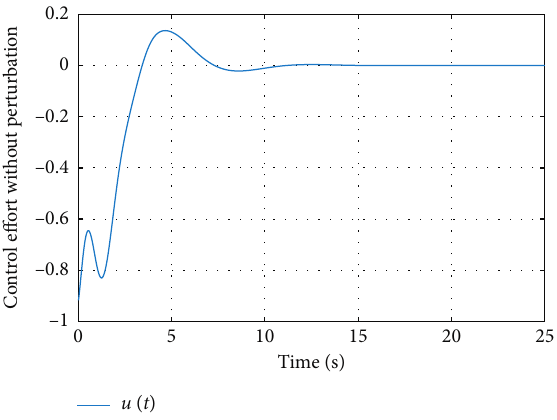
Figure 9: DIP system control effort with